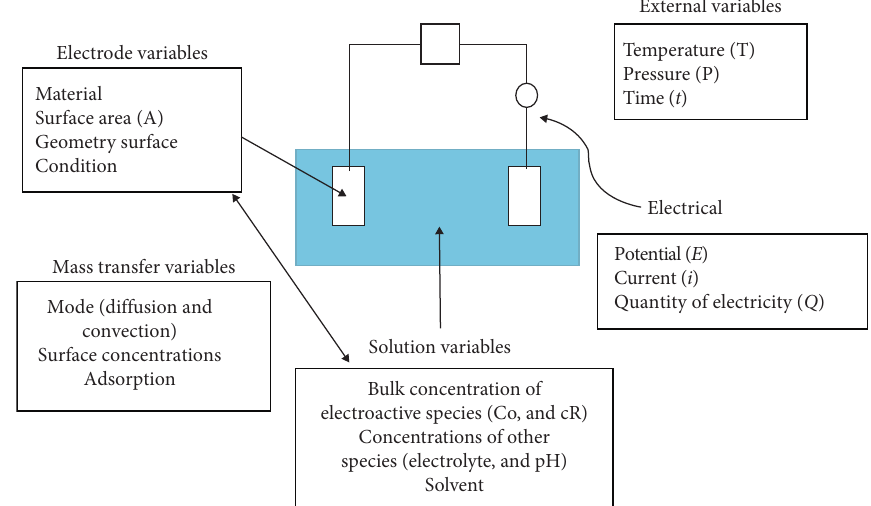
Figure 23: Factors that affect the interfacial process of the electrochemical reaction